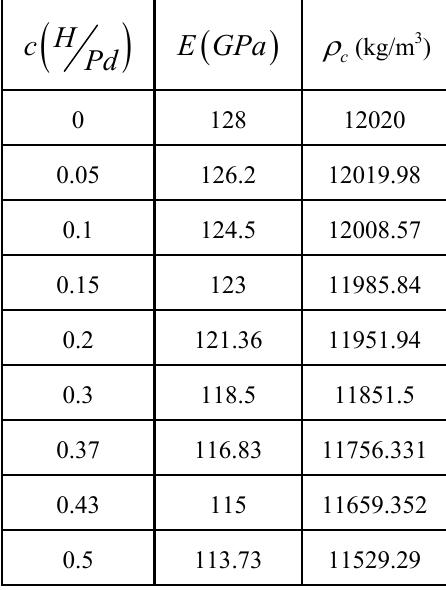
Table 6. Material Properties for the palladium film at different hydrogen